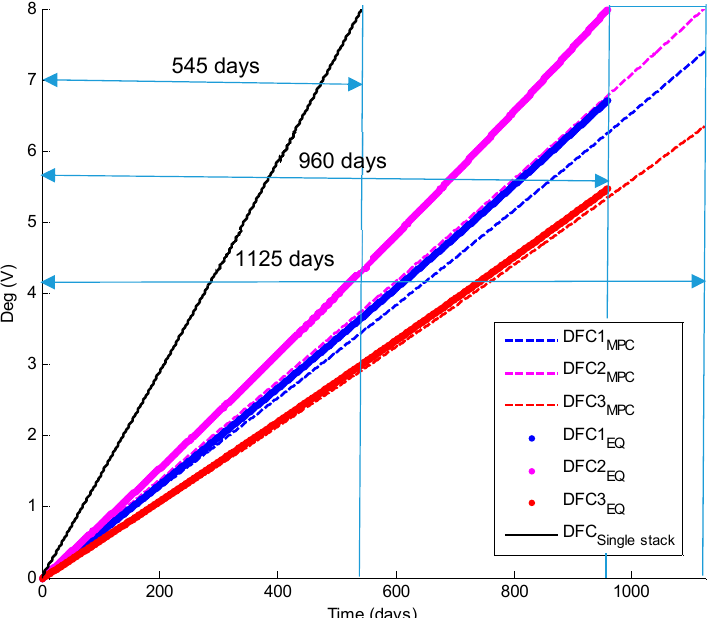
Figure 5. Comparative of stacks degradation in the three cases (single-stack FC system, multi-stack FC system with equal power distribution, and multi-stack FC system with MPC controller). Single-stack lifespan: Day 545. Multi-stack FC system with equal power distribution lifespan: day 960. Multi-stack FC system with MPC control algorithm lifespan: Day 1125.